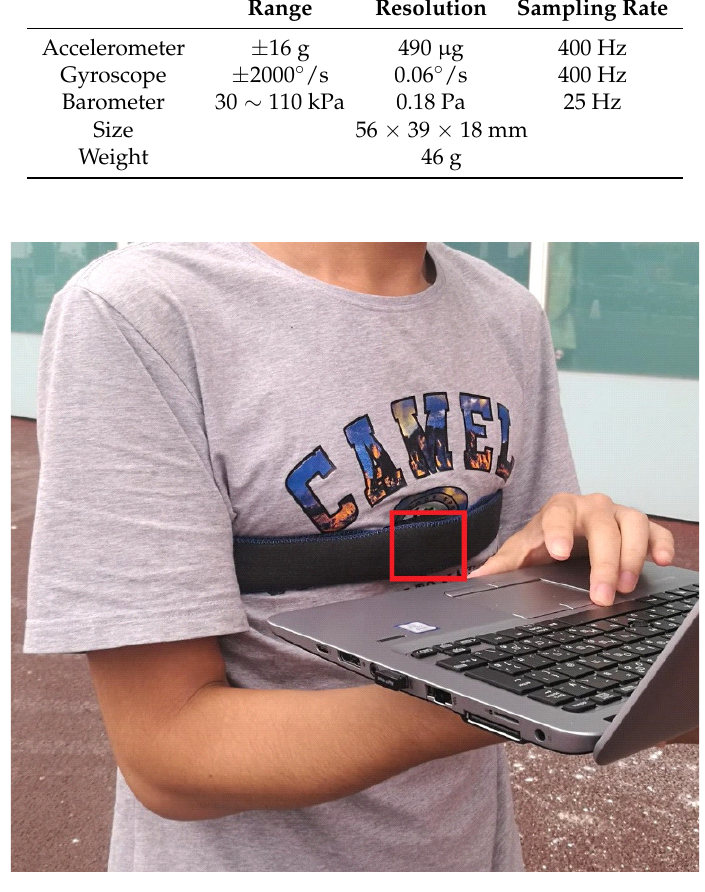
Figure 1. A prototype system of the chest-mounted intertial measurement unit (IMU)-based pedestrian dead reckoning